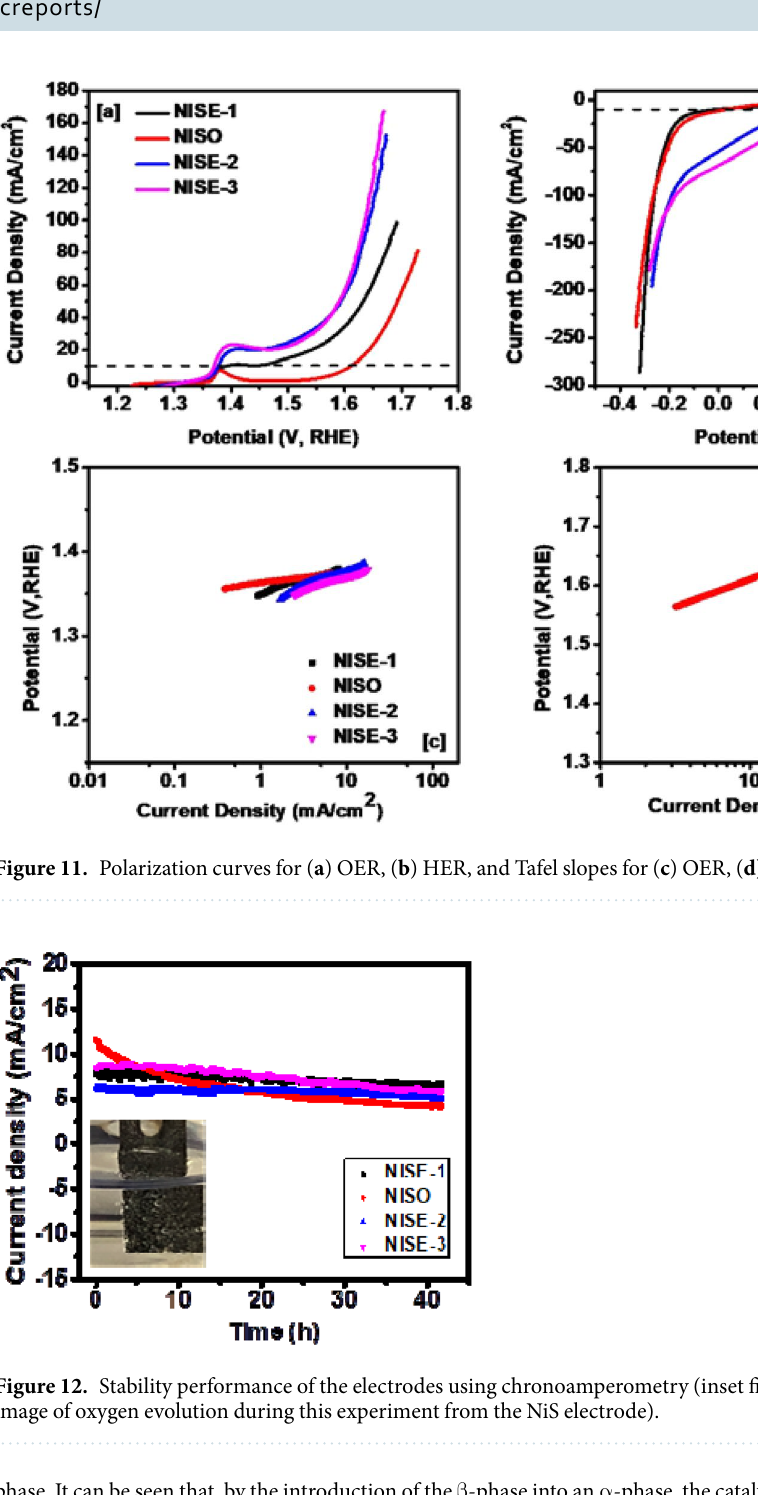
phase. It can be seen that, by the introduction of the β -phase into an α -phase, the catalytic efficiency can be dras- tically enhanced. The series resistance of the synthesized samples was analyzed using EIS. The frequency versus impedance of the NiS synthesized from complex (1) at various temperatures (200, 300 and 400 °C) is shown in Figure S10a–c, ESI. The lowest charge transfer resistance was achieved, as expected, for the sample synthesized at 400 °C, which means more rapid electrochemical reaction kinetics for metal-like β -NiS. The Nyquist plot showed in Figure S10d–f, ESI appear as small semicircles, indicating high mobility of ions that increase the conductivity. For the NiS sample synthesized from complex (2) , the frequency versus impedance is shown in Figure S11. The lowest resistance achieved was about 7 Ω, which is higher than the resistances achieved for all the samples obtained from complex (1) . Similarly, the semicircle generated in the sample from complex (2) is bigger than all semicircles in samples from complex (1) (Figure S11b, ESI). Hence, it can be inferred that the samples synthesized from the xanthate complexes with short alkyl chain have higher conductivity than the sample from the complex containing the longer alkyl chain.